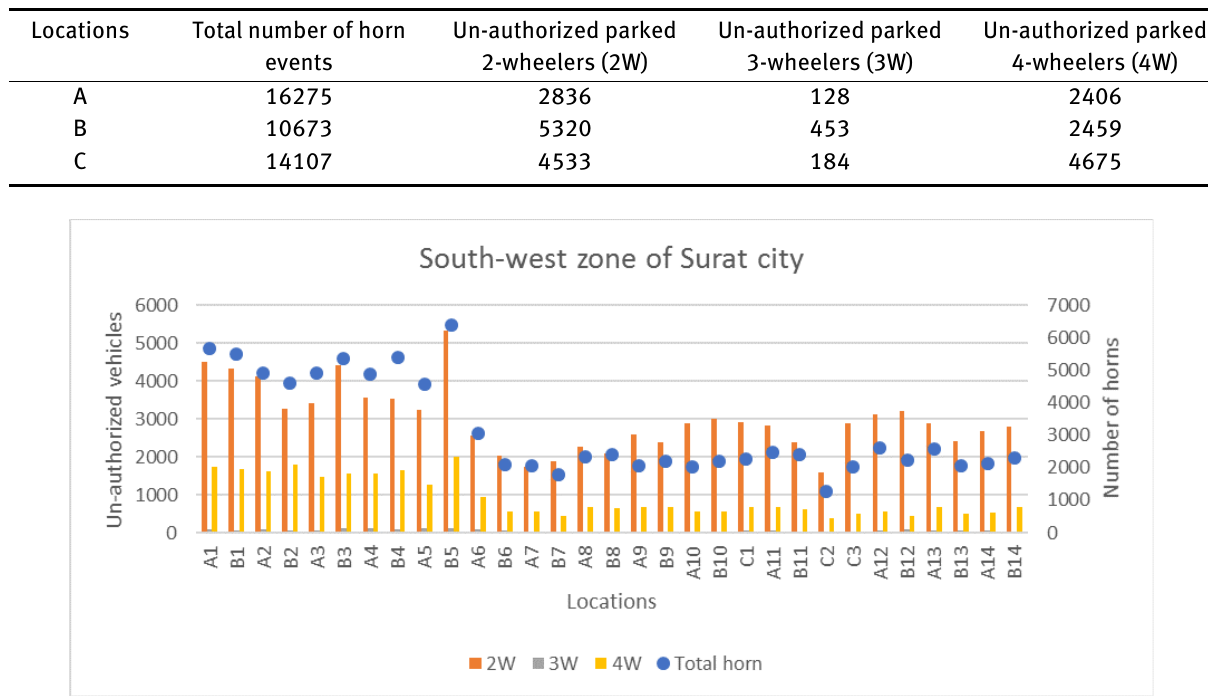
Figure 9: Correlation between un-authorized vehicles and number of horn event (South-West zone of Surat city)